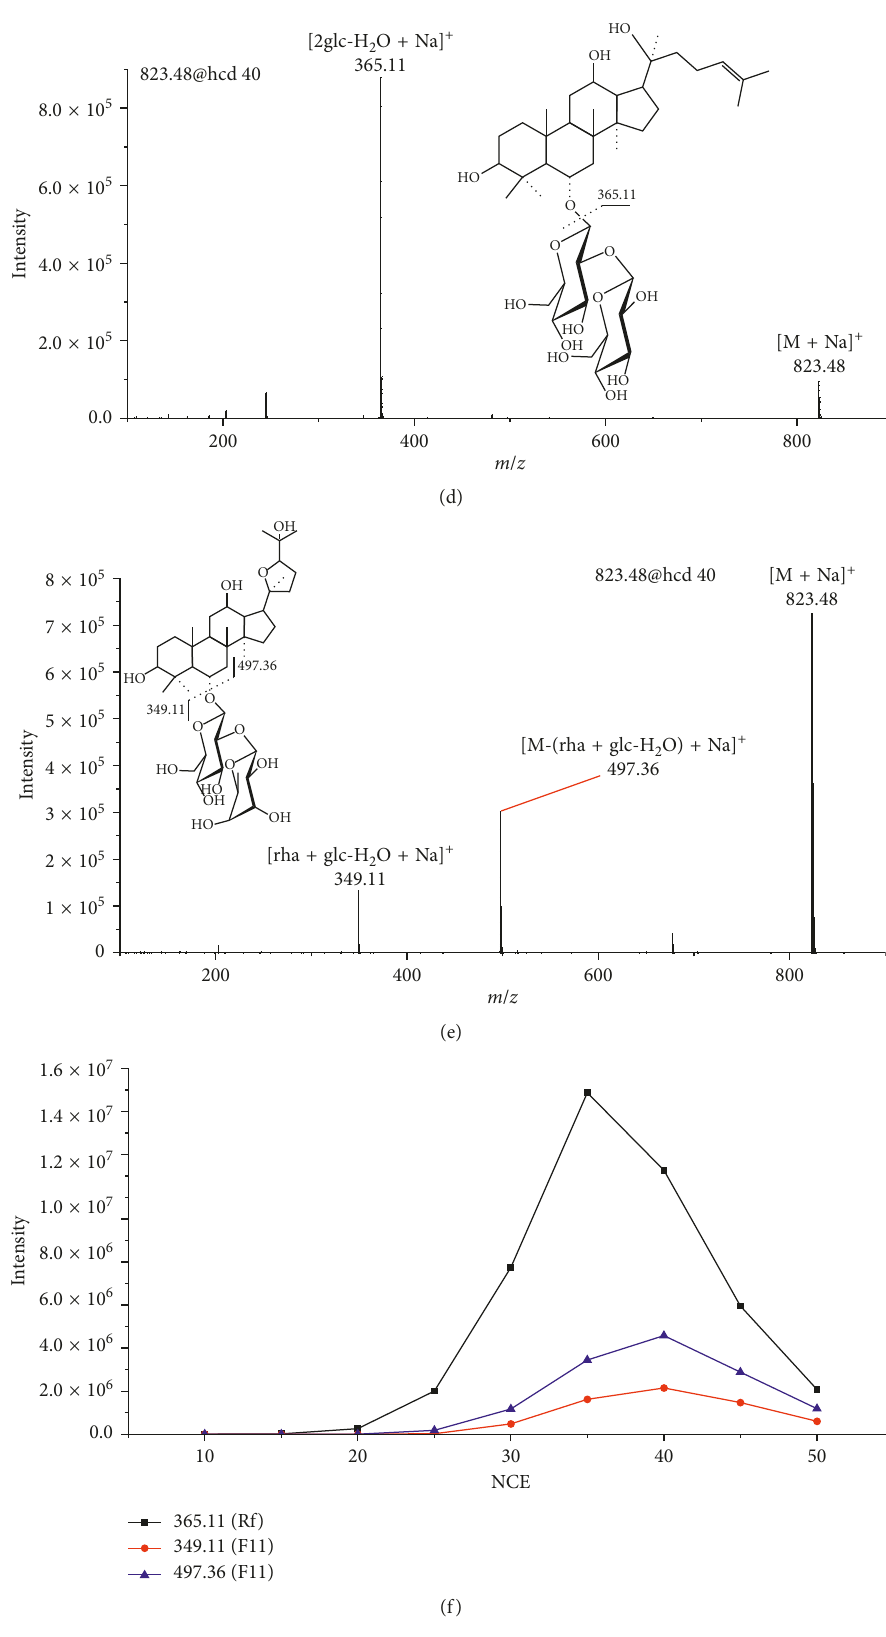
Figure 3: MS 2 spectra of [M +HCOO] for (a) Rf and (b) F11 in the negative mode; MS 2 spectra of [M +Na] + for (d) Rf and (e) F11 in the positive mode. The signal intensity of product ions for Rf and F11 with respect to the NCE in the negative (c) and positive (f) modes (glc − represents glucose and ara represents